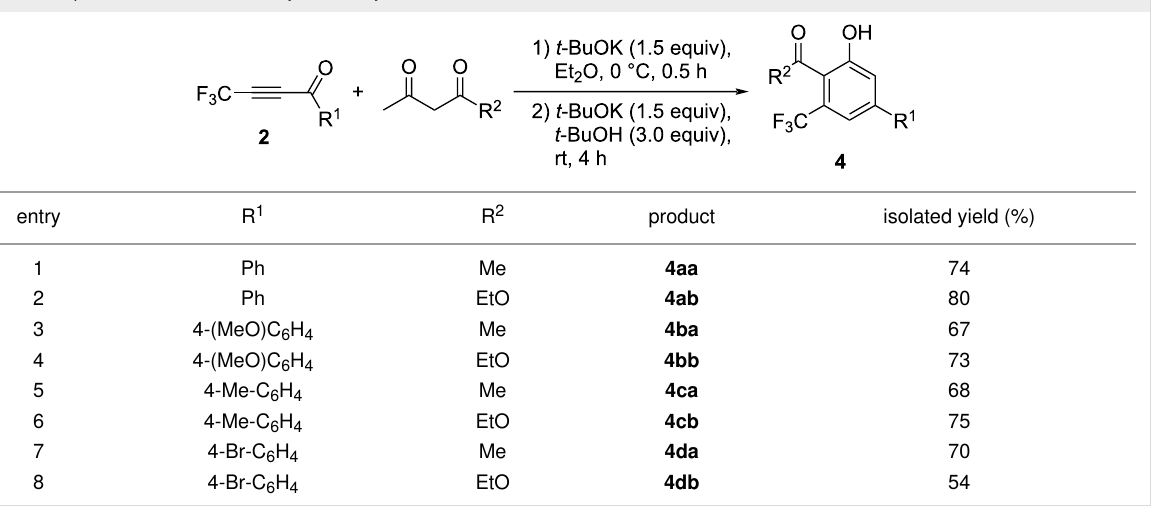
Table 4: Preparation of the trifluoromethylated salicylate derivatives 4